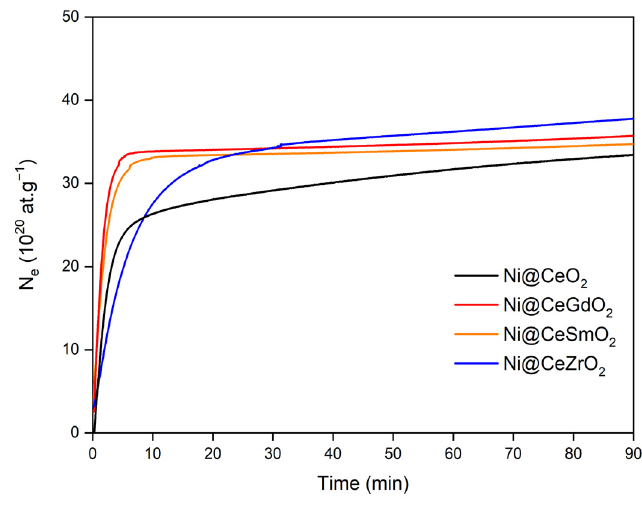
Figure 6. Evolution of the number of exchanged oxygen atoms during IOIE at 400 °C for Ni@CeO 2 , Ni@CeGdO 2 , Ni@CeSmO 2 and Ni@CeZrO 2 .